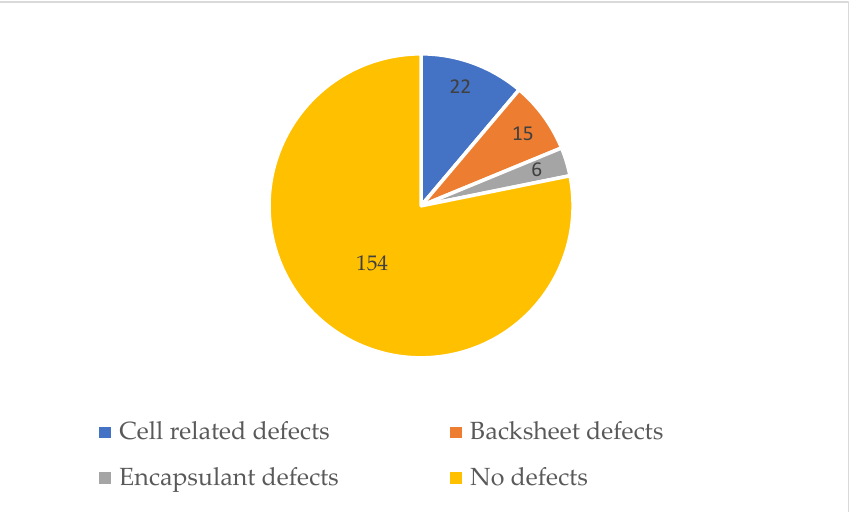
Figure 2. Degradation analysis result involving 1.9 million modules across 197 installations [30].